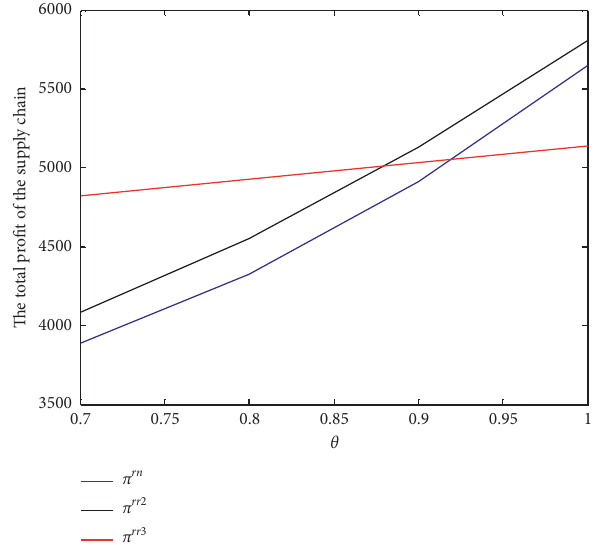
Figure 3: The total profit of the supply chain under retailer price cap